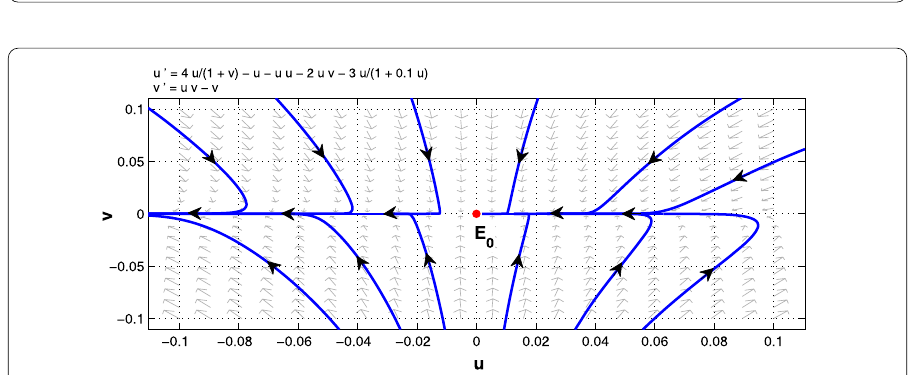
Figure 7 Dynamic behavior of system (5.1) with r 0 = 4, d = 1, k = a = m = 1, c = 0.5, p = 2, m 1 = 1, m 2 = 0.1, q = 3, and E = 1